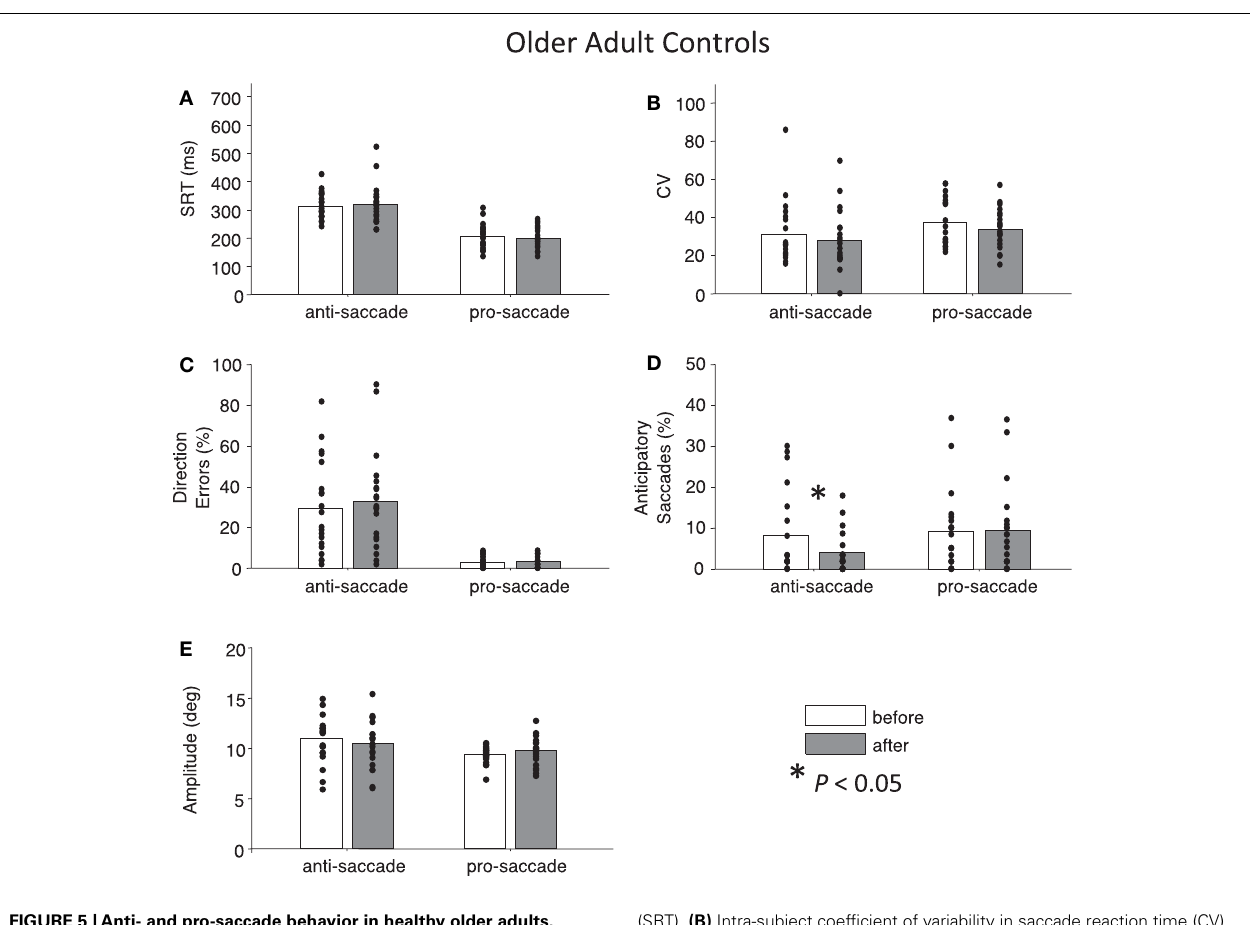
FIGURE 5 |Anti- and pro-saccade behavior in healthy older adults. Horizontal axis now indicatesTask (pro- or anti-saccade) and legend indicates theTime factor (before or after a period of rest). (A) Saccade reaction time